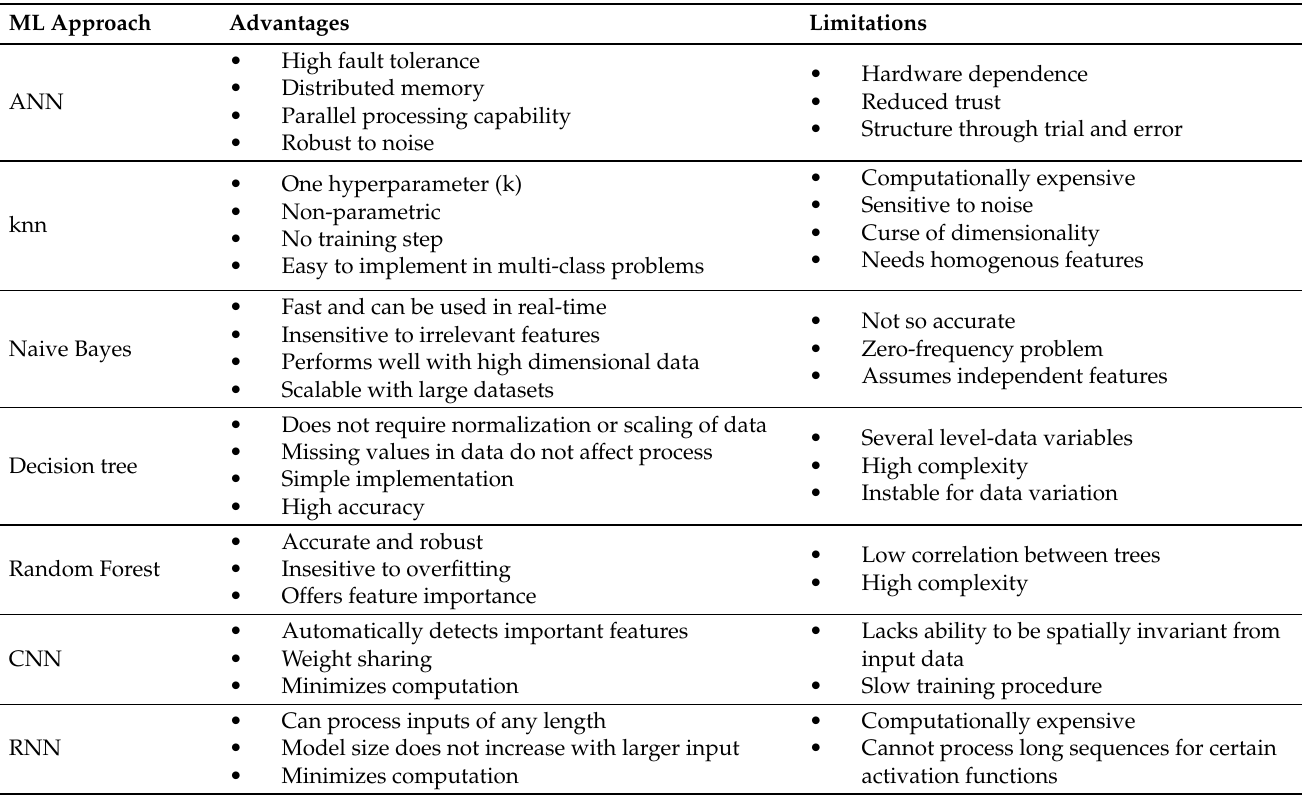
Table 2. Advantages and limitations of supervised ML